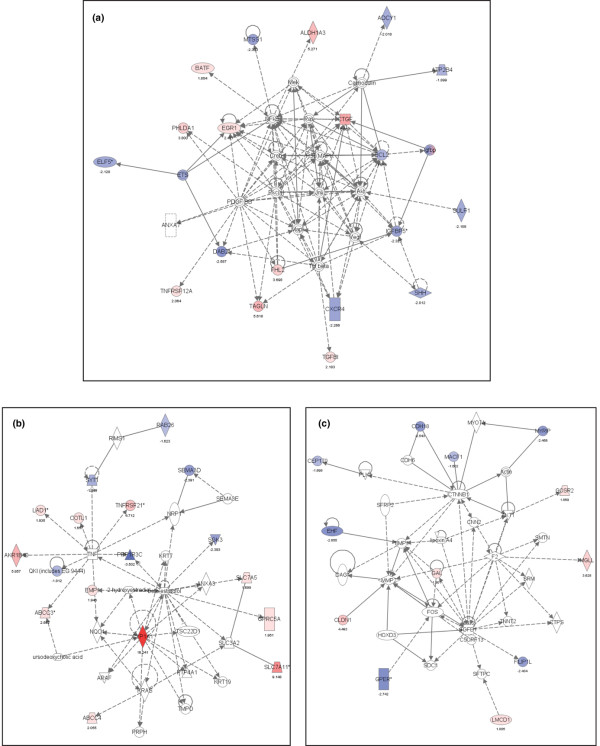
Pathway analysis of the Ox-E/ER gene signature. (a) Top scoring gene network represented in the Ox-E/ER gene signature. Ox-E/ER genes upregulated by oxidative stress are colored in red, and oxidative stress downregulated genes are colored in blue. Intensity of color reflects the magnitude of the average fold changes across the three oxidants as listed below the gene. Uncolored nodes are added by the Ingenuity Pathway Systems software, and are not present in the Ox-E/ER signature. Solid lines signify direct gene-gene interactions, whereas broken lines represent indirect relationships that may require secondary effectors not depicted in the network. All connections are supported by at least one published report or from canonical information stored in the Ingenuity Pathway Knowledge Base. (b) Number 2 scoring network represented in the Ox-E/ER gene signature. (c) Third top scoring network represented in the Ox-E/ER gene signature. ER, estrogen receptor; Ox-E/ER, oxidant-sensitive estrogen/ER gene signature.